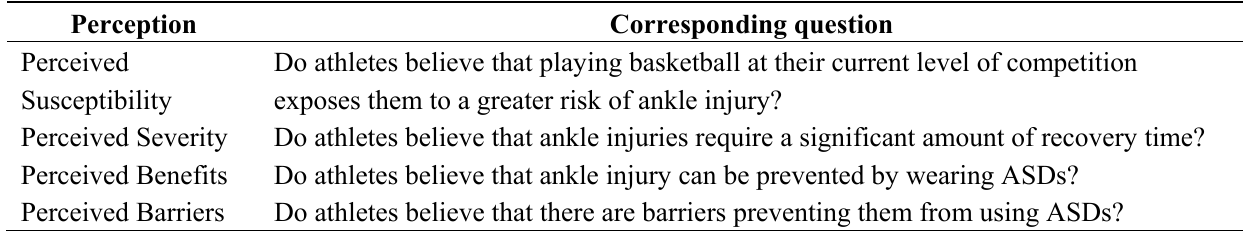
Table 1. Health Belief Model (HBM) perceptions examined in questionnaire using corresponding